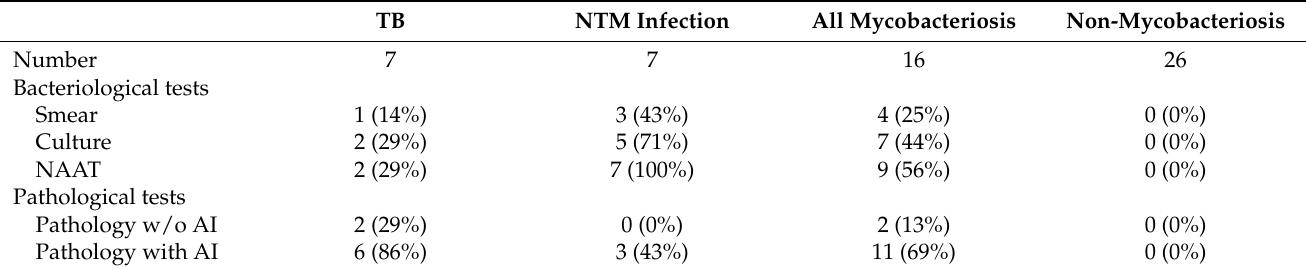
Table 2. Results of the bacteriological and pathological examinations.